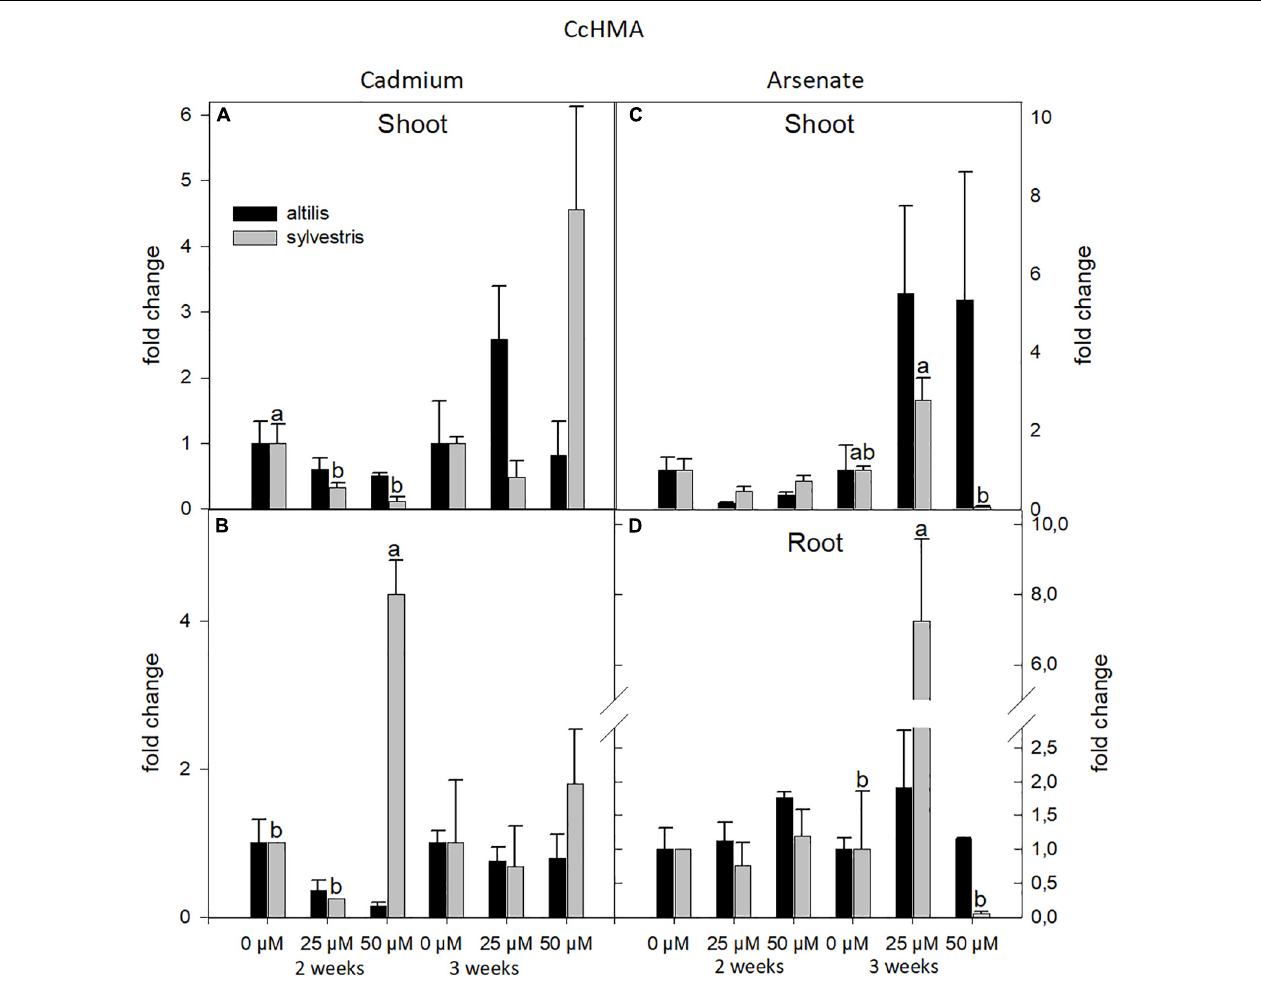
FIGURE 6 | The level of gene expression of HMA in seedlings of altilis and sylvestris grown up to 2 and 3 weeks under Cd (A,B) and As (C,D) at different concentrations. The fold change is the Ct value with respect to the housekeeping genes (EF1 α and GAPDH) that is considered 1. The error bars represent the error mean of three biological replicates. Letters indicate only significantly different values ( P ≤ 0.05) between concentrations in each moment of sampling.